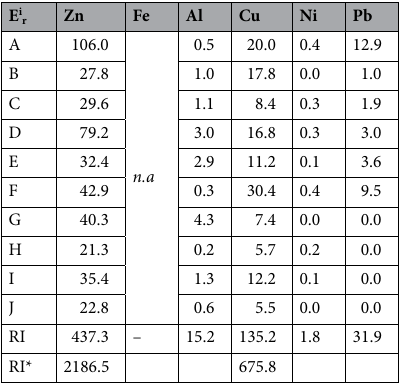
Table 4. Single factor potential ecological risk (E i r ) and comprehensive potential ecological risk index RI evaluated for each of the urban sinkholes under study in Cancun. RI * Carcinogenic risk. Fe toxicity coefficient not available ( n.a .); risk factors were not